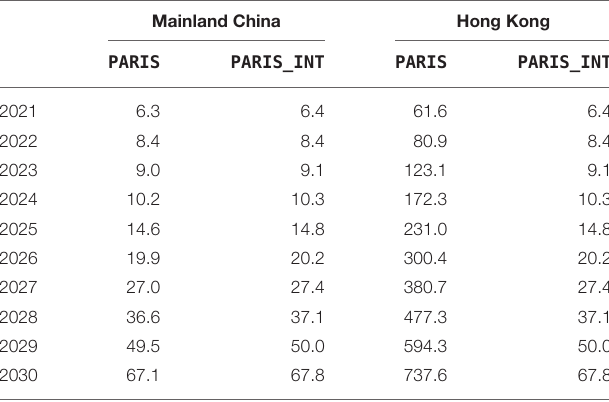
TABLE 5 | Carbon prices under moderate mitigation